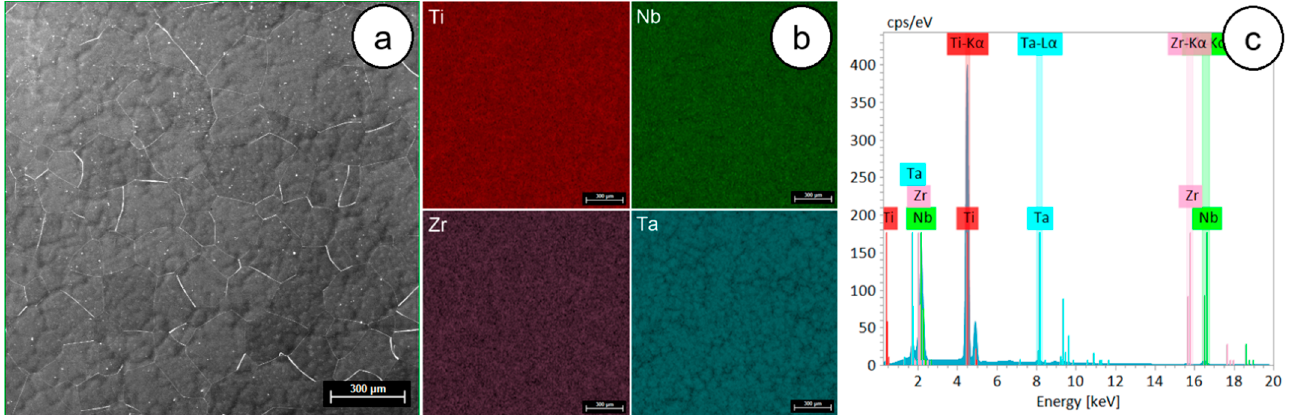
Figure 3. SEM-BSE image of the AR TNTZ alloys microstructure ( a ); SEM-EDS colorized maps. showing the main alloying elements distribution ( b ); EDS spectra of AR TNTZ alloy ( c ). Table 1. Computed global chemical composition of TNTZ alloy in AR state. Element At. No. Mass, [% wt.] Abs. Error, [%] Rel. Error, [%]